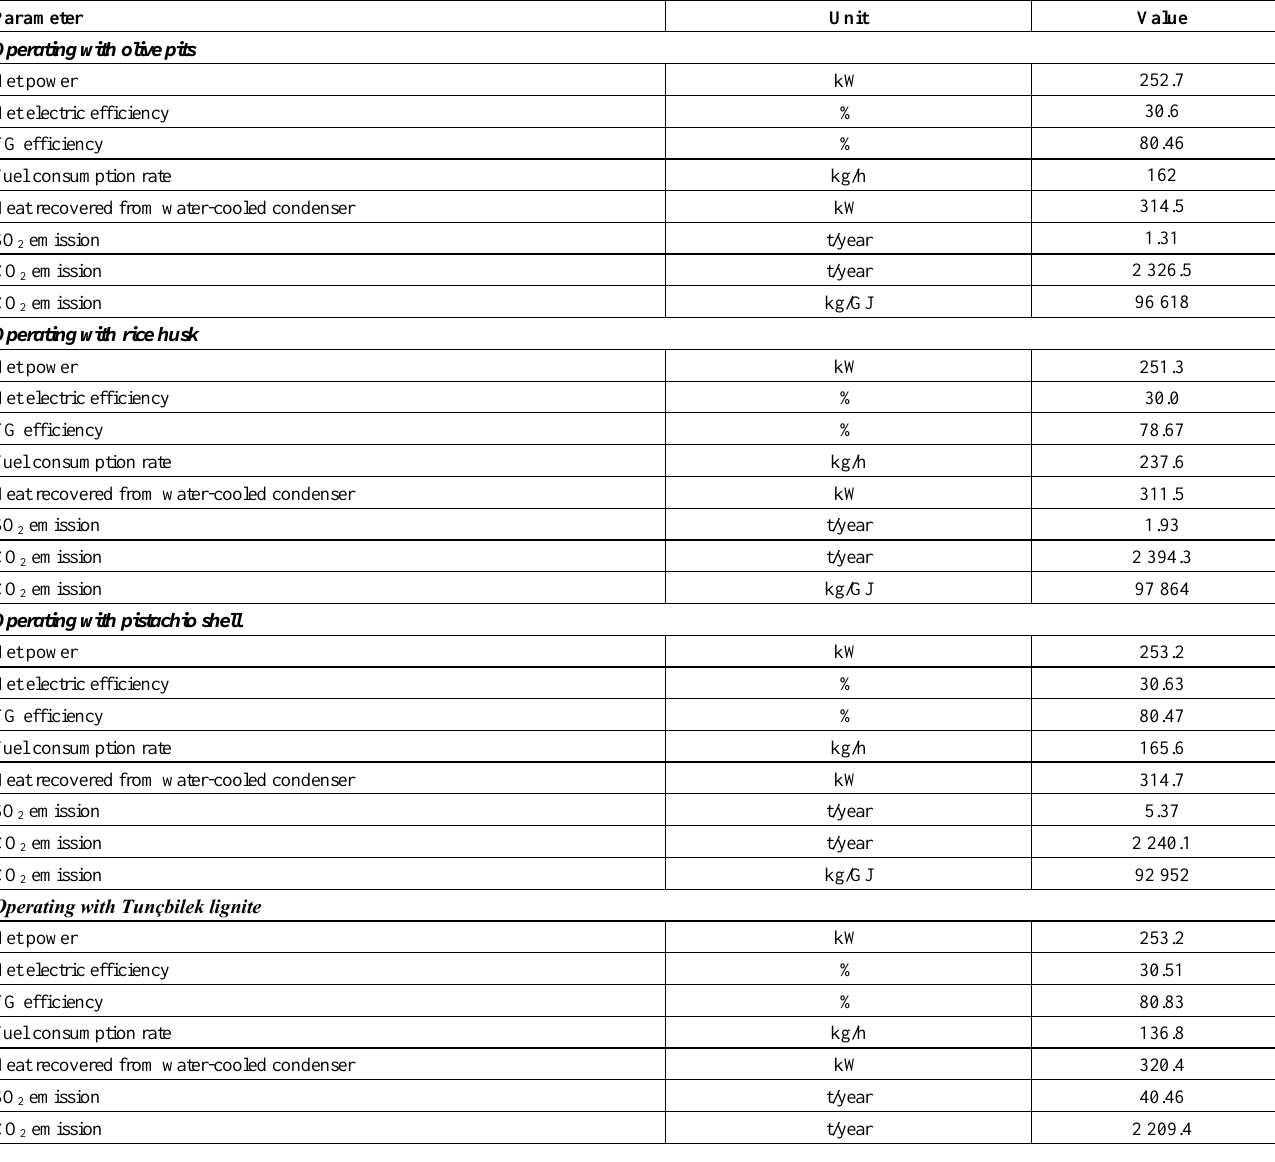
T ECHNICAL AND ENVIRONMENTAL DATA OF THE SIMULATED TRIGENERATION SYSTEM FOR DIFFERENT TYPES OF